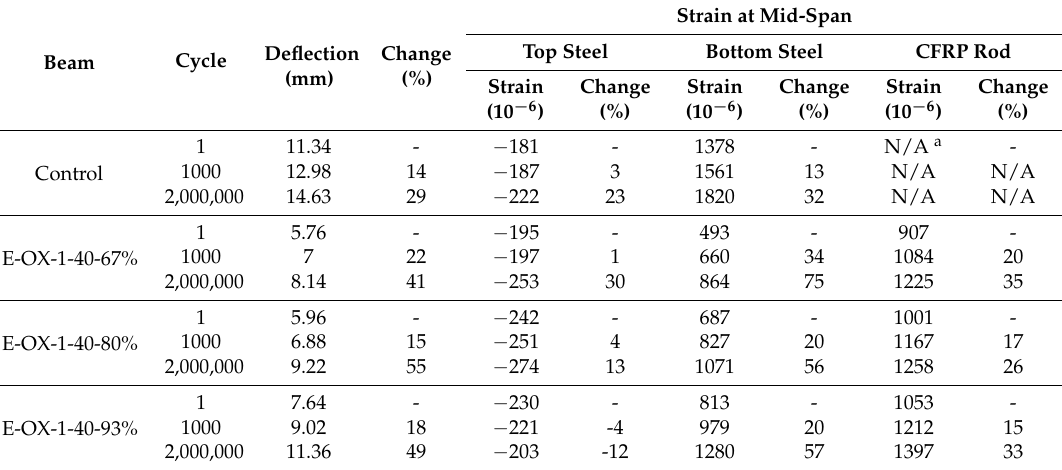
Table 5. Fatigue test results at upper load limit (Bond length).